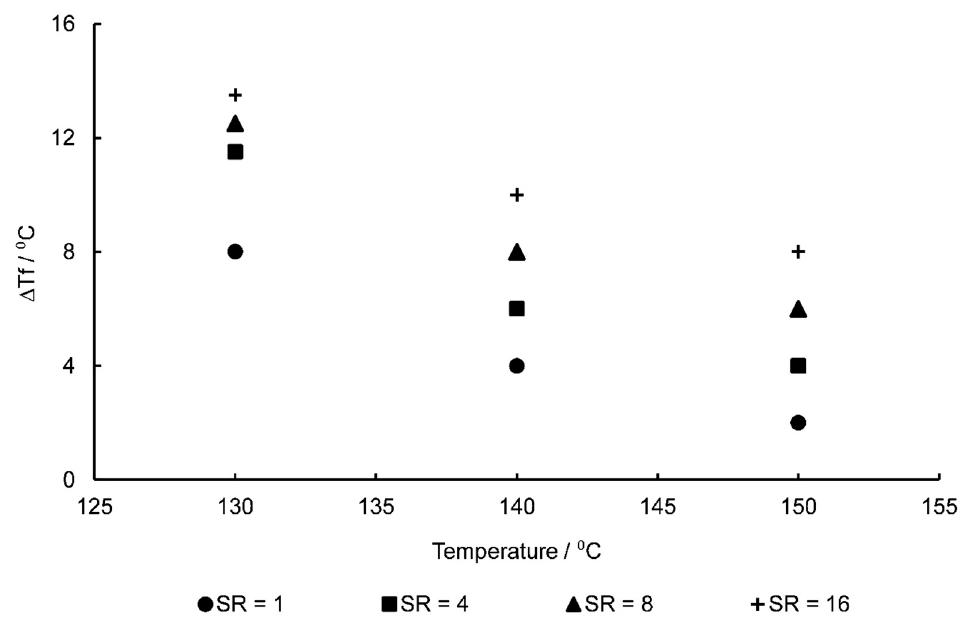
Figure 11. ∆ Tf against temperature for EB stretching of PEEK.